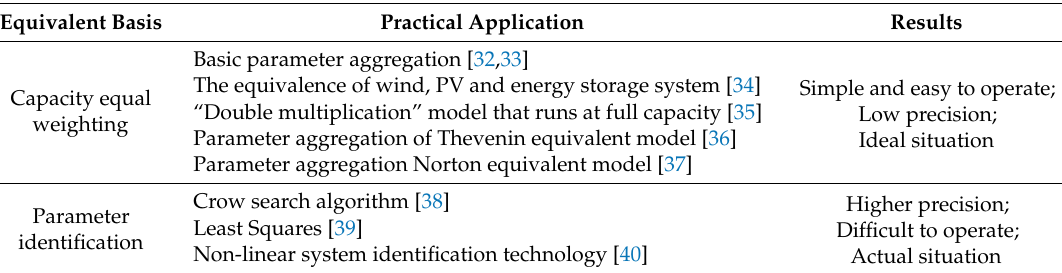
Table 2. The single-machine equivalent method of PV power